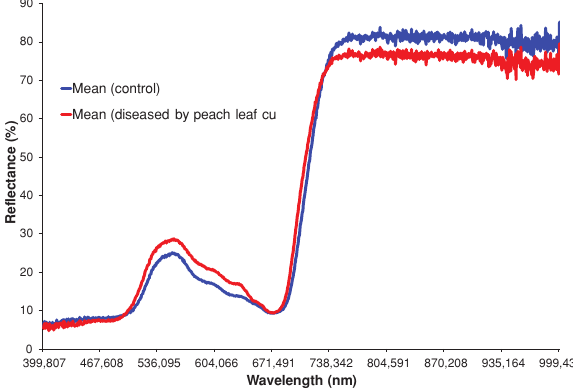
Figure 1. Average spectral profi les of control and infected